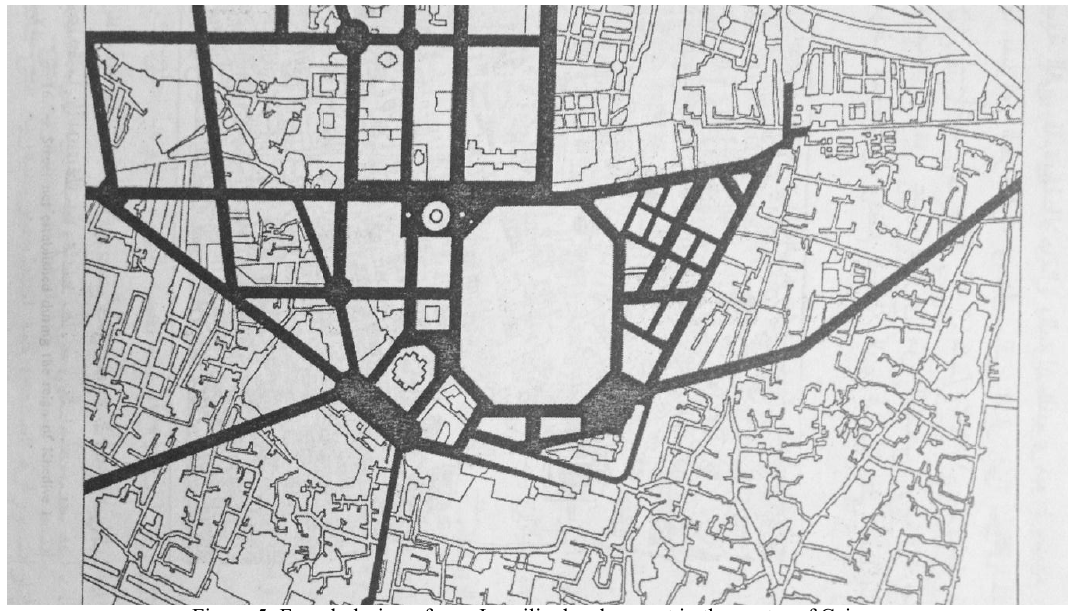
Figure 5: French design of new Ismailia development in the center of